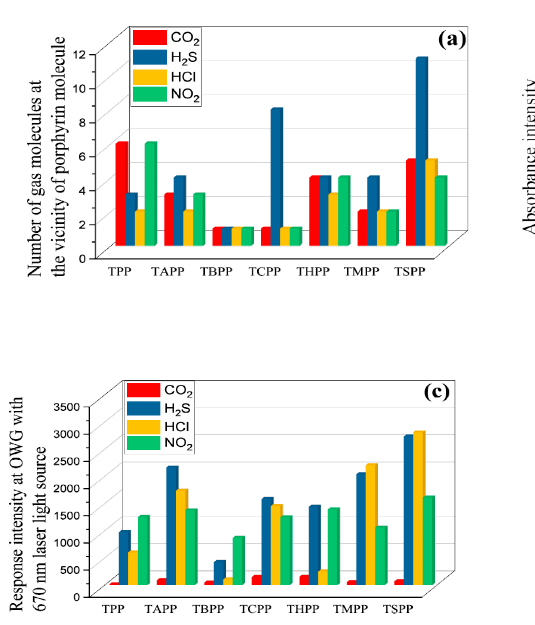
Figure 10. ( a ) Number of gas molecules in vicinity of 0.3 nm around each porphyrin molecule achieved by molecular dynamic simulation; ( b ) Absorbance change of porphyrin films after exposure to CO 2 , H 2 S, HCl, NO 2 gases (saturated) at the 670 nm wavelength; ( c ) Response intensity change of each porphyrin films exposed to gases in optical waveguide with laser source as 670 nm.